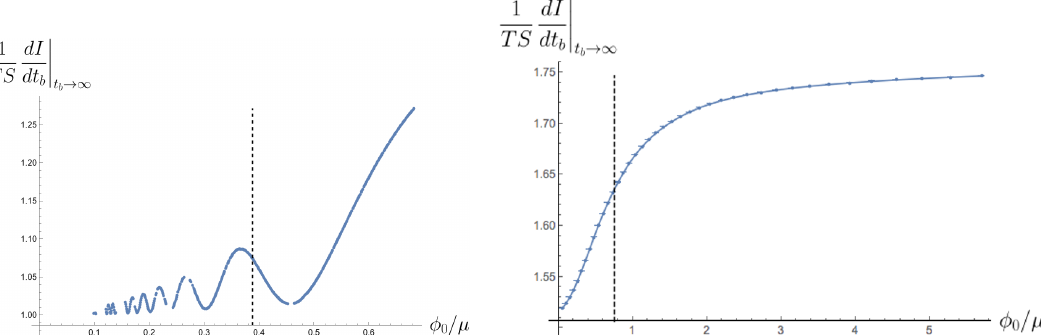
Figure 25 . Left: asymptotic action complexity for charged solutions with q = 1 at constant T/µ = 0 . 15 . The dashed line corresponds to the Temperature at which the solution changes type. Right: asymptotic action complexity for uncharged solution at T/µ = 0 . 25